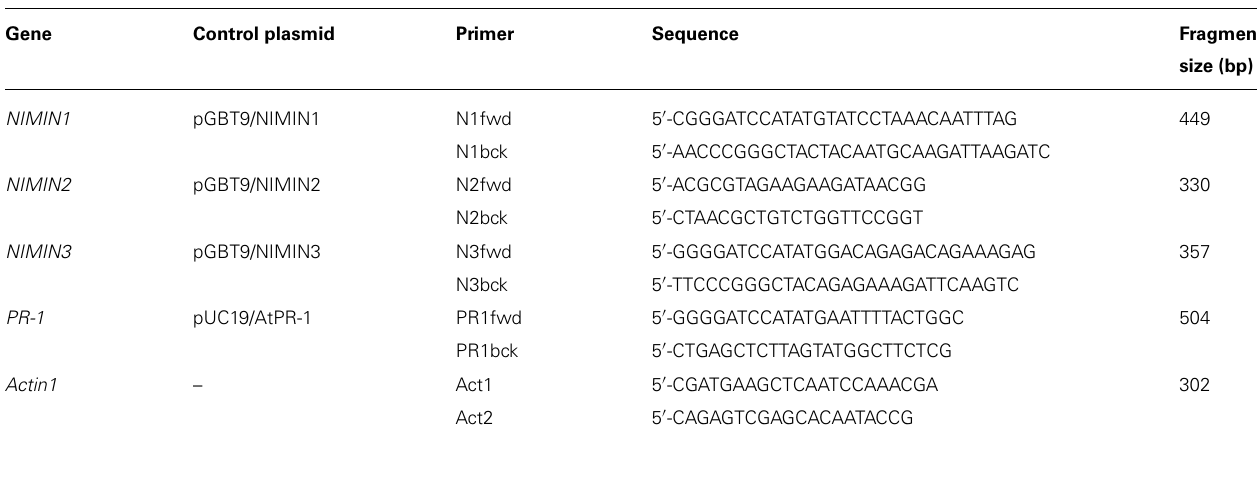
Table 1 | Primers and control plasmids used in RT-PCR